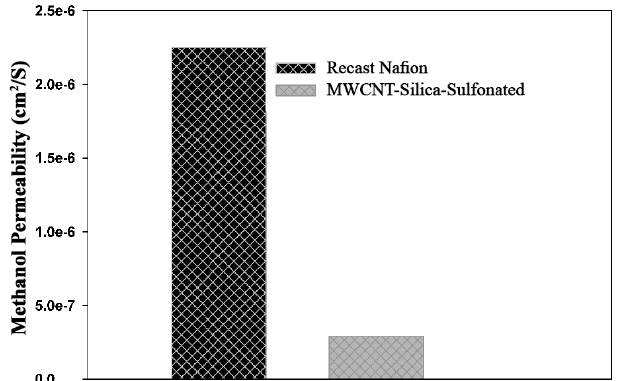
Fig. 5. Methanol permeability of Nafion/CNT@SiO 2 -SO 3 H in comparison with recast Nafion selectivity (S.s/cm 3